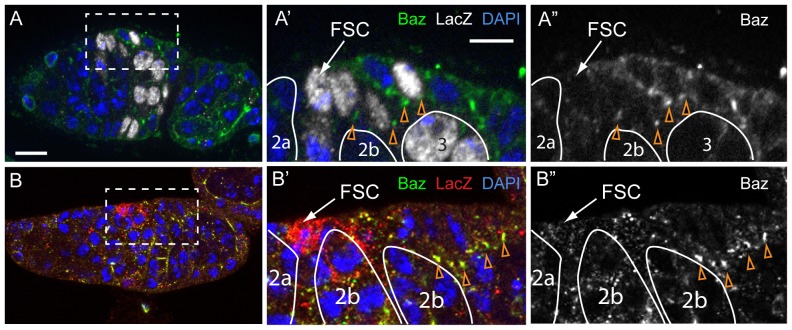
Bazooka is not localized to the apical domain of FSCs.
A. A germarium with a mature LacZ+ FSC clone (white) stained for Baz (green) and DAPI (blue). Baz is distributed diffusely in the FSC and localized to the apical domain in downstream follicle cells (orange triangles). B. A Notum-LacZ germarium stained for LacZ (red) to identify the FSC, baz (green) and DAPI (blue). Again, baz is diffuse and difficult to detect in the FSC, but upregulated in the downstream follicle cells (orange triangles). The boxed regions in A and B are magnified in A′ and A″, and B′ and B″ respectively. A″ and B″ show the Baz channel only. Germ cell cysts are outlined in solid white lines and stages are indicated. Anterior is to the left. Scale bar represents 5 µm.